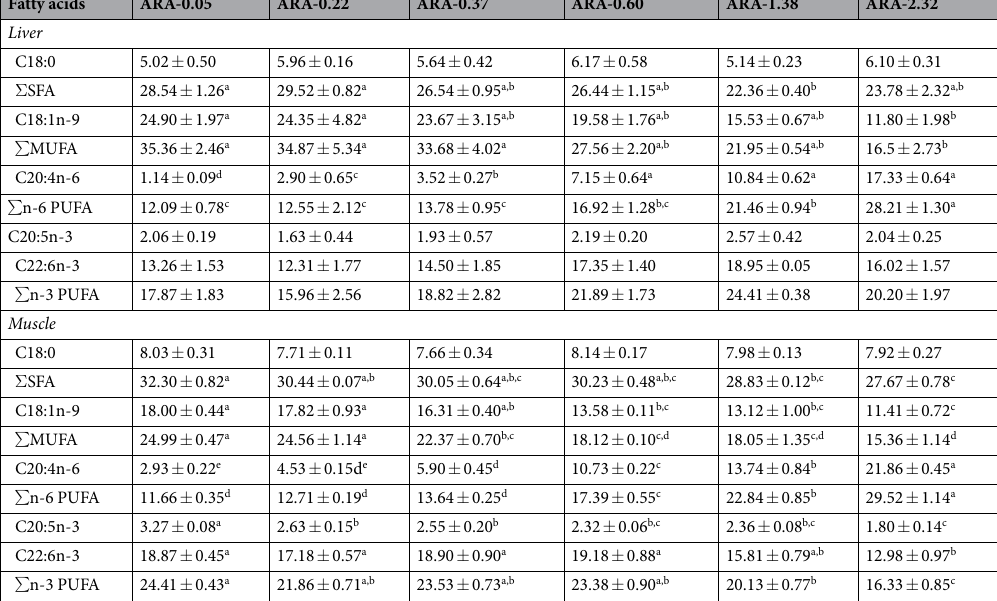
Table 2. Fatty acid profiles of liver and muscle of the experimental fish (% total fatty acid, means ± standard error, n = 3). Values in the same row with no common superscript letters are significantly different ( P < 0.05). SFA, saturated fatty acid; MUFA, monounsaturated fatty acid; PUFA, polyunsaturated fatty